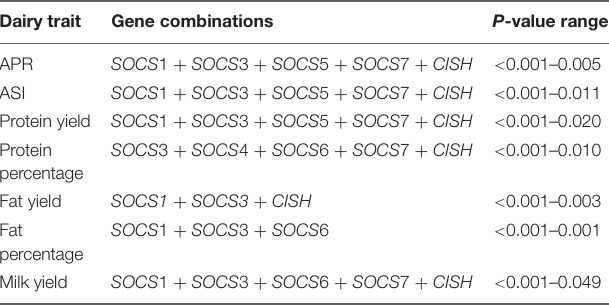
TABLE 3 | Suppressors of cytokine signalling gene SNP combinations associated with dairy traits.